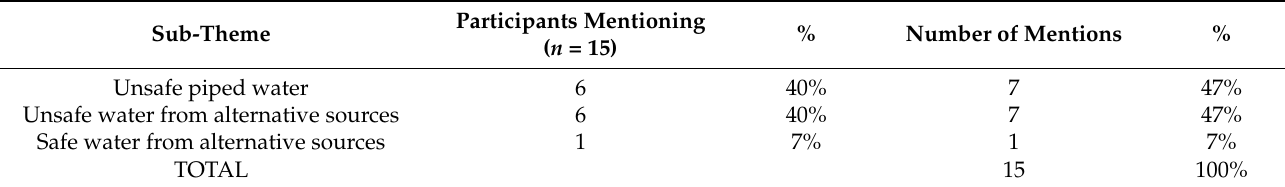
Table 7. Water quality before the water crisis.